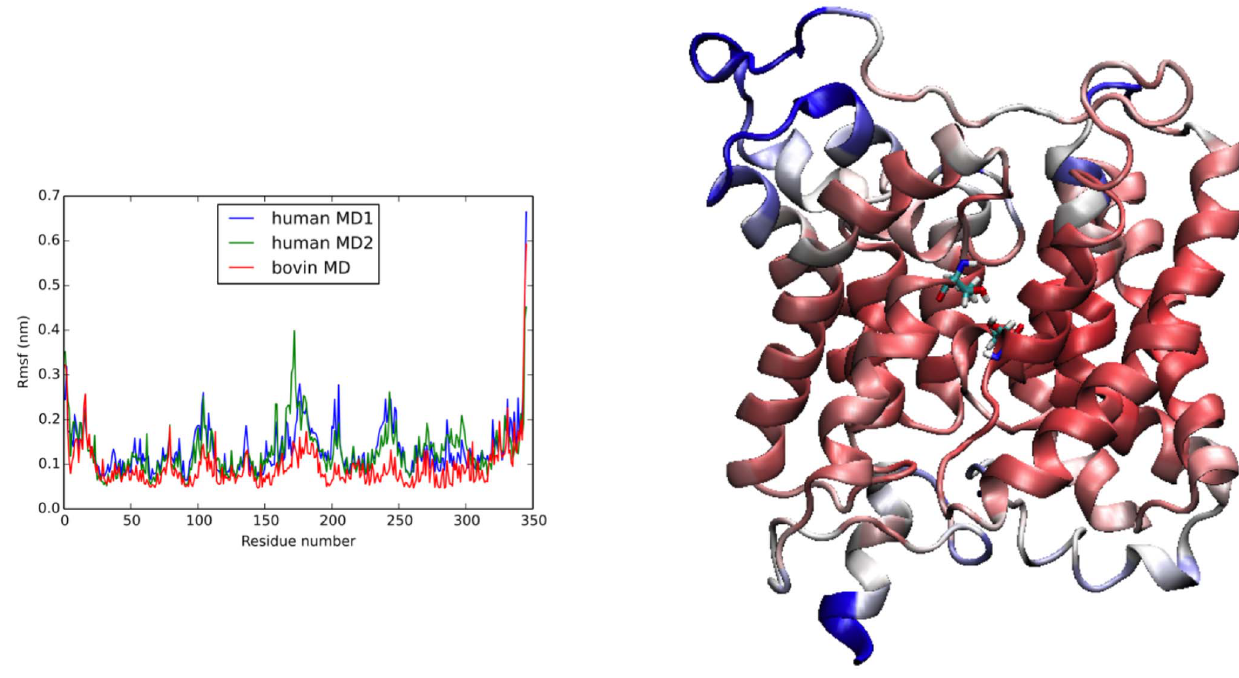
Figure 5. C a fluctuations computed from each simulation. (a) Root Mean Square Fluctuation (RMSF), RMSF of simulations on human model (blue and green) and bovine structure in red. (b) Same information projected on the 3D structure. In red, residues exhibiting low fluctuations, and in blue, residues with high fluctuations.